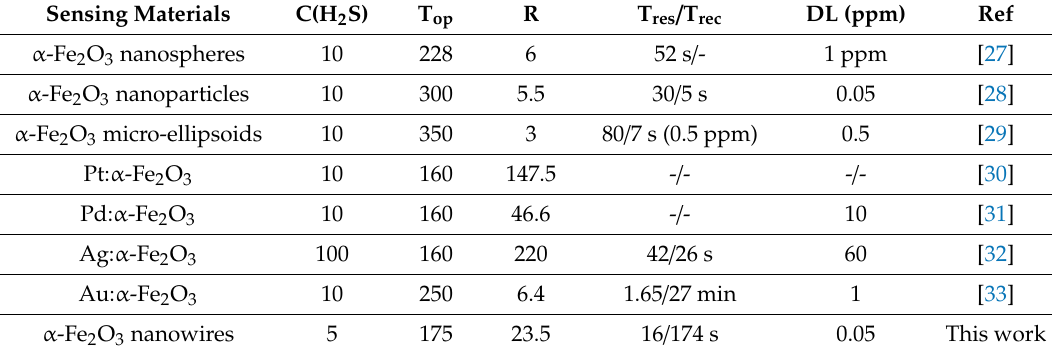
Table 1. Comparison between di ff erent α -Fe 2 O 3 based H 2 S sensors. (C(H 2 S): H 2 S concentration; T op